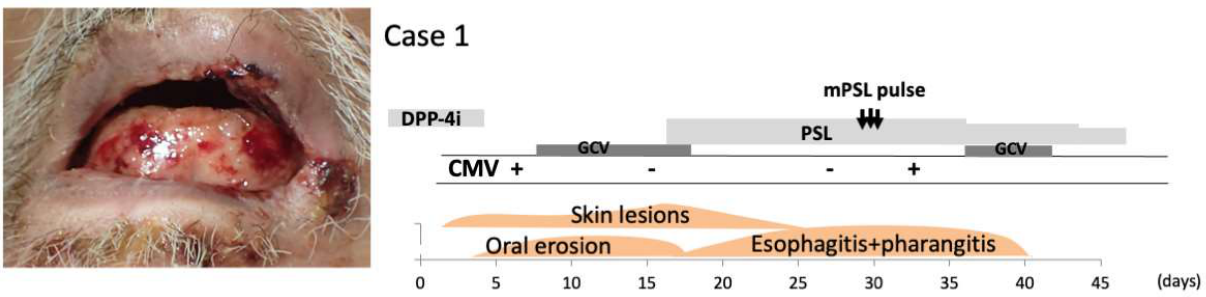
Figure 1. Case 1: Oral erosions caused by mucous membrane pemphigoid and its clinical course. Steroid pulse therapy triggered CMV antigenemia and esophageal erosions worsened.